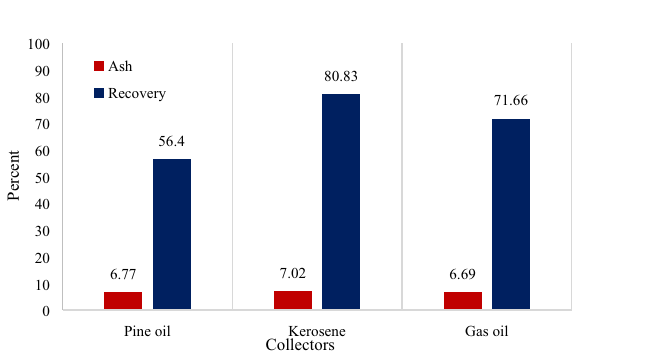
Figure 5. Ash content and recovery of gilsonite rougher flotation concentrate under the conditions of using pine oil, kerosene and gas oil